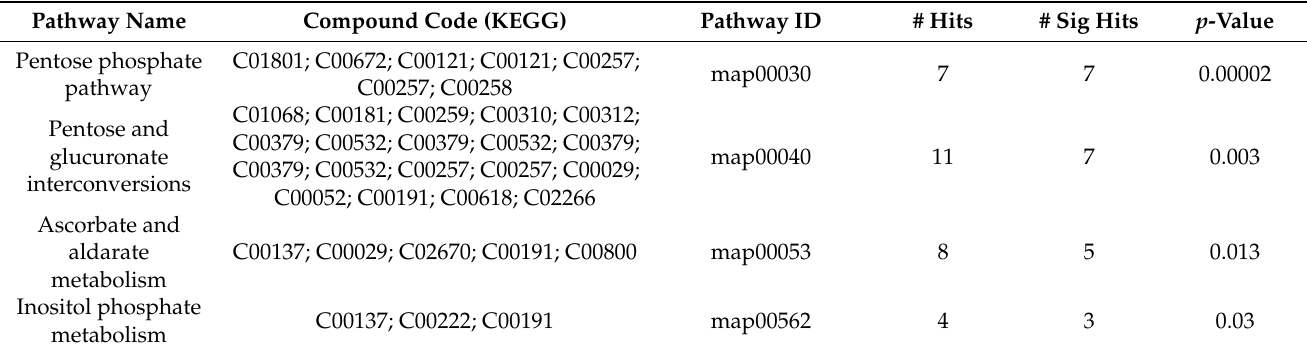
Table 3. Pathway alterations associated with changing FTOE in infants with TGA undergoing atrial